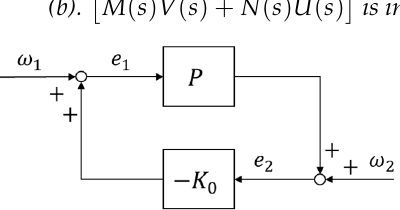
Figure 11. Block diagram of internal stability analysis. Figure 10. Block diagram of the small gain theorem.